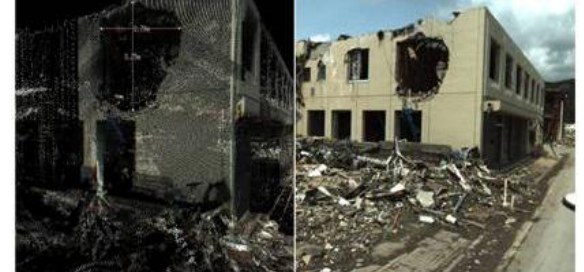
Figure 6. Two images of the holed building by tsunami – left: point cloud data, right: photography image 4. SUGGESTION